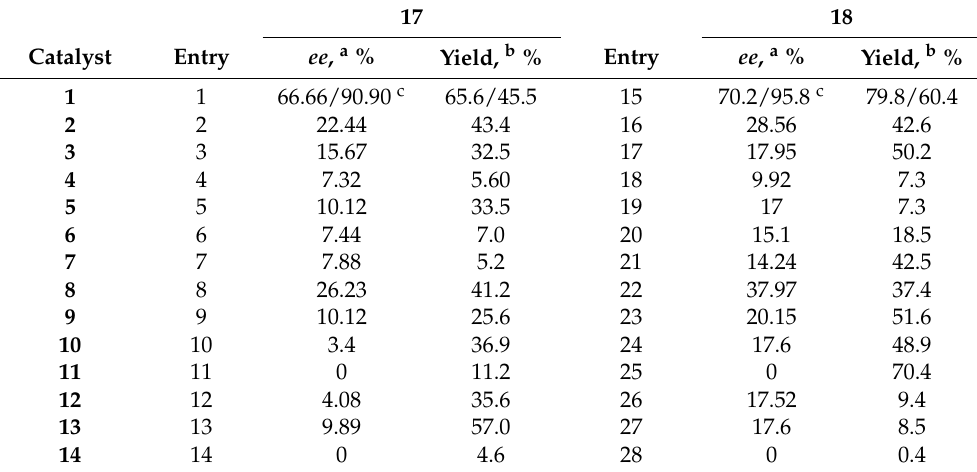
Table 4. Experimental outcomes for C-alkylation of amino acid derivatives 17 and 18 .